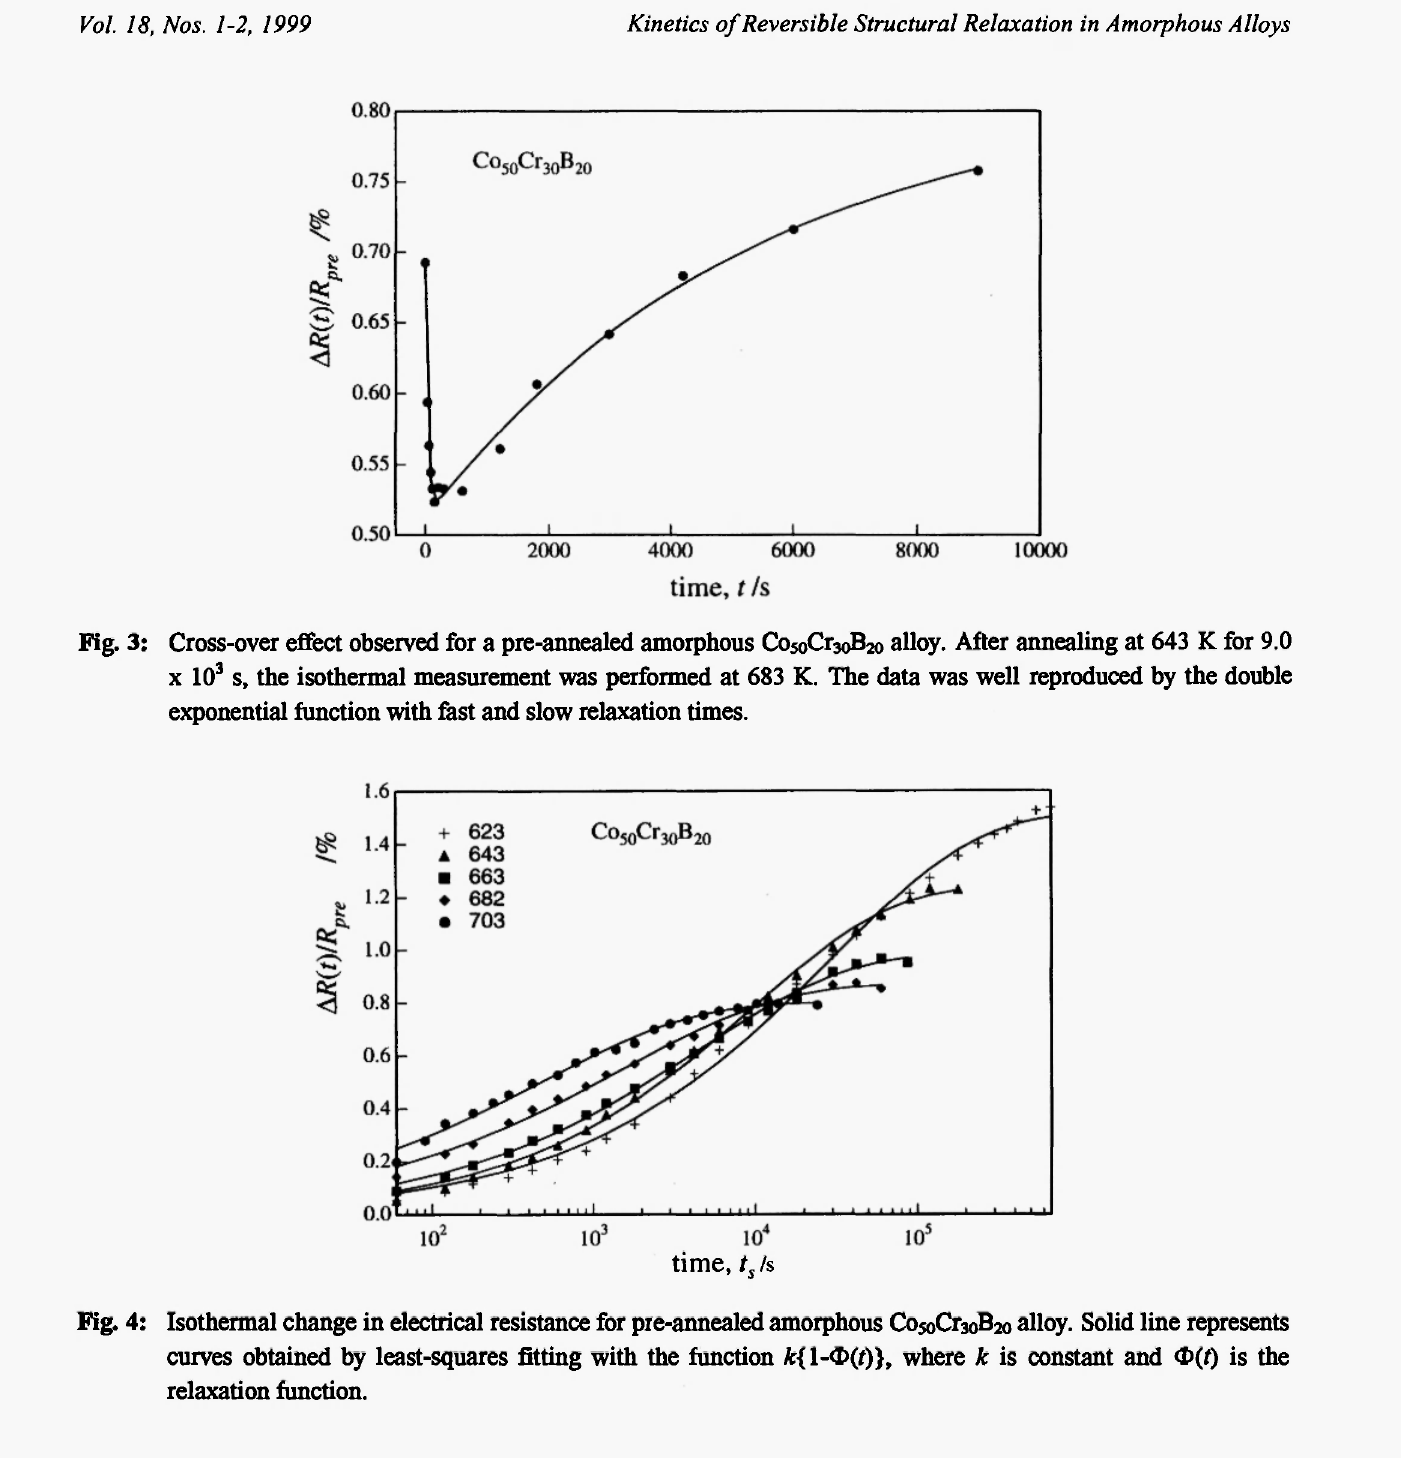
Fig. 4: Isothermal change in electrical resistance for pie-annealed amorphous CO5OCT3OB curves obtained by least-squares fitting with the function &{1-Φ(ί)}, where k is constant and Φ(0 is the relaxation